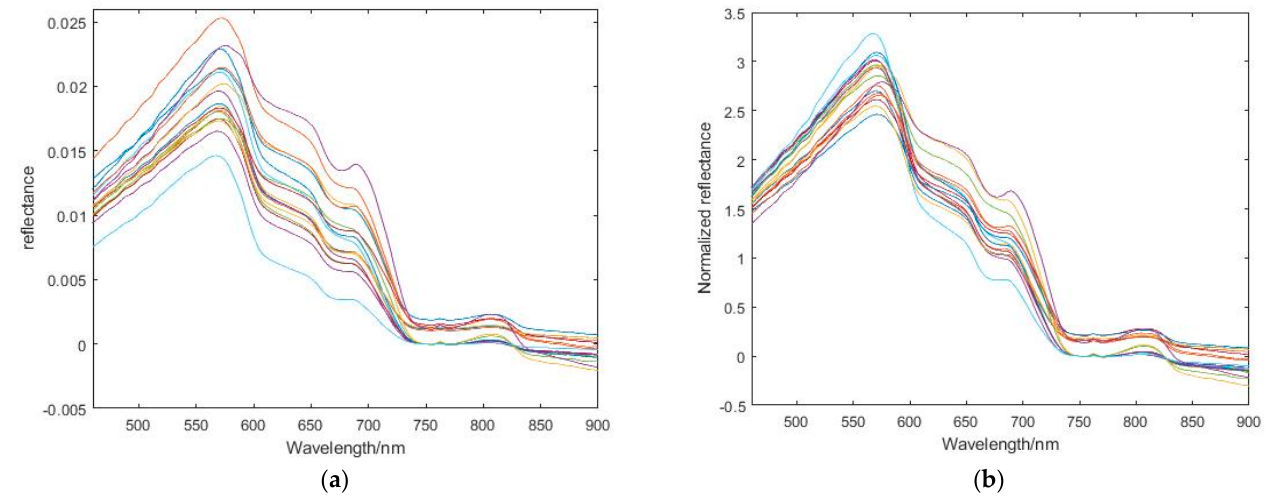
Figure 6. Original and normalised spectral curves. ( a ) is the original spectral curve, ( b ) is the normalised spectral curve.